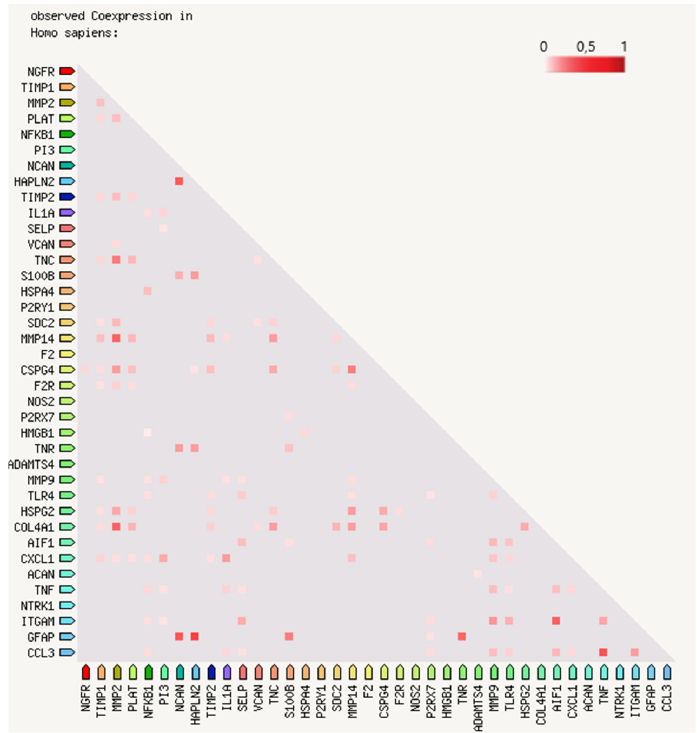
Figure 2. Bidimensional matrix of RNA expression patterns and protein co-regulation. The 38